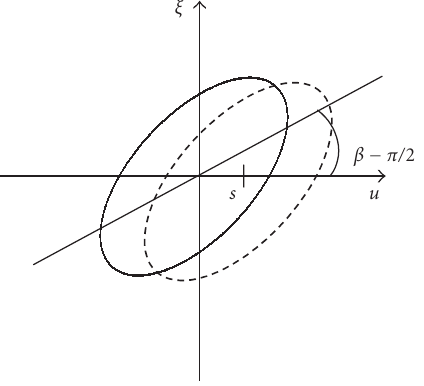
Figure 3: Schematic representation of the cross-AF of two signals, before (solid line) and after (dashed line) shifting of one of the sig-